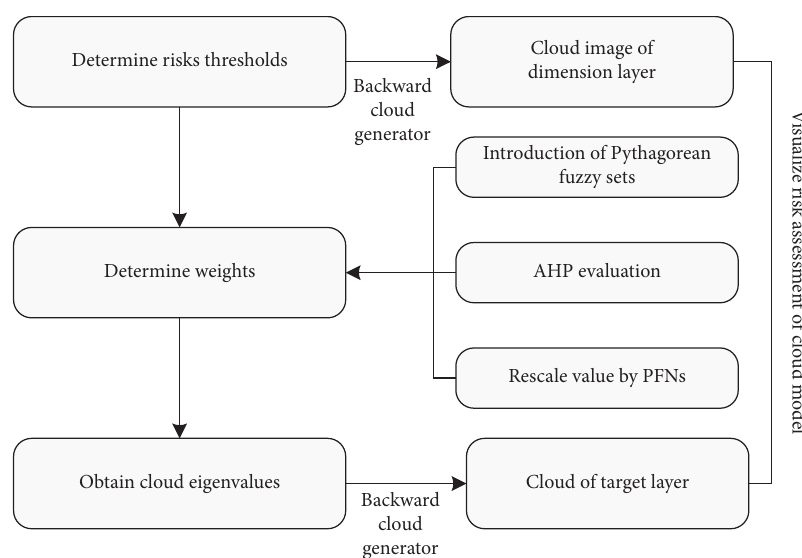
Figure 2: Flowchart of project risk assessment using a cloud model.